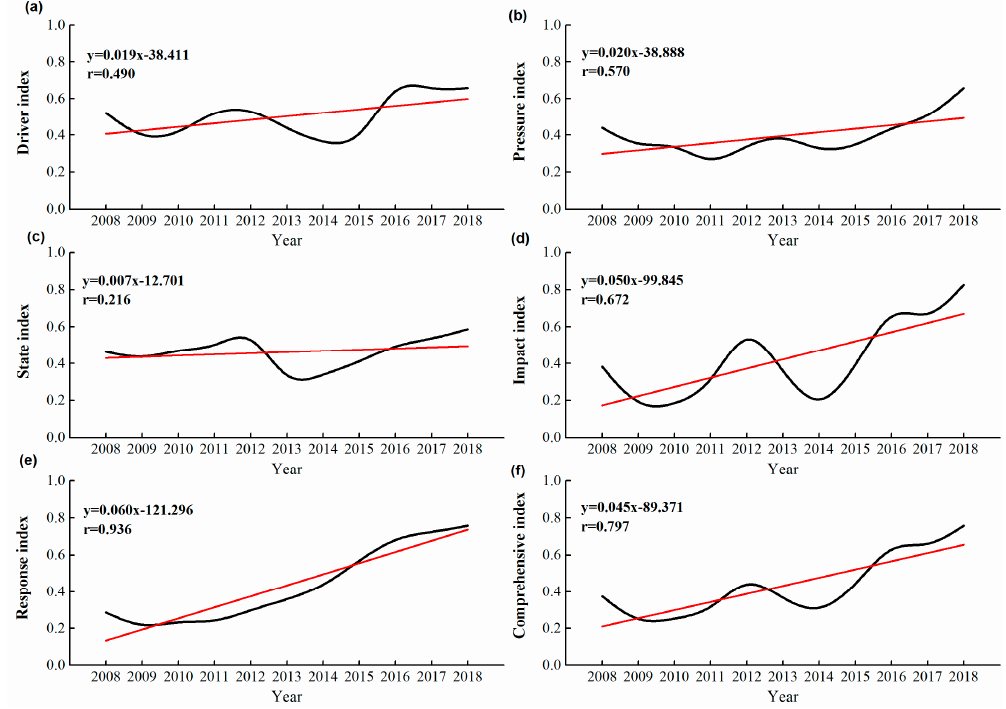
Figure 3. Inter-annual variation of the DPSIR index. ( a ) Inter-annual variation of the driver index, ( b ) inter-annual variation of the pressure index, ( c ) inter-annual variation of the state index, ( d ) inter-annual variation of the impact index, ( e ) inter-annual variation of the response index, and ( f ) inter-annual variation of the comprehensive index.